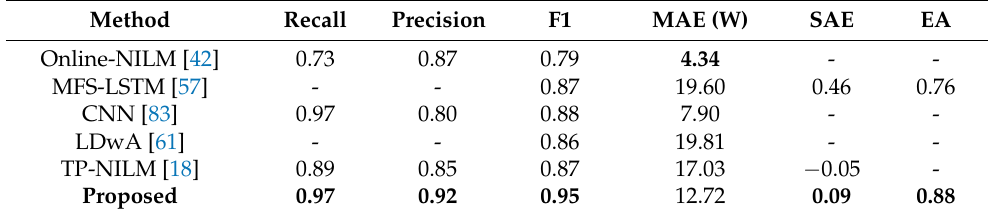
Table 9. Comparison results with existing non-intrusive load monitoring methods for the